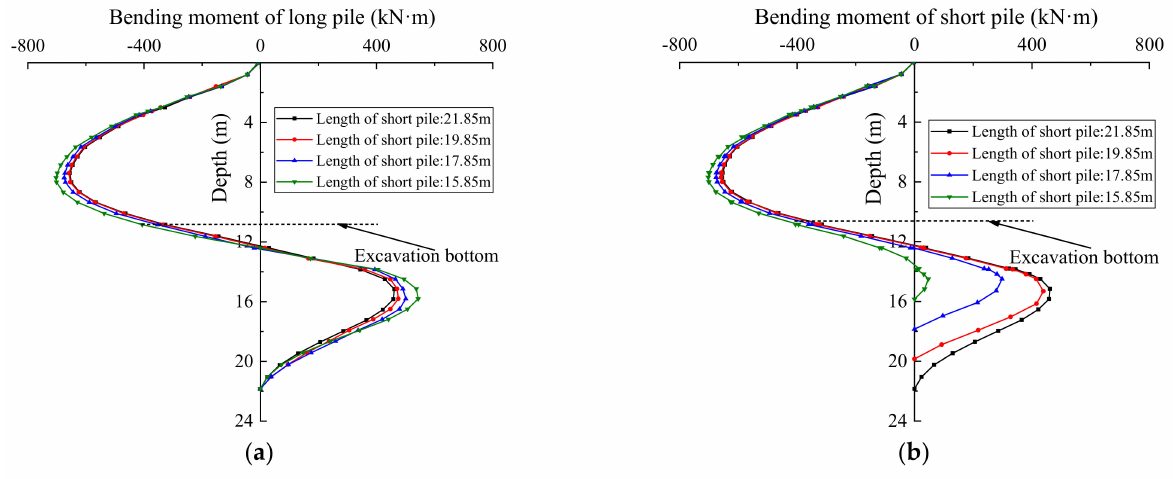
Figure 15. Bending moment of piles under different short pile lengths: ( a ) long pile; ( b ) short pile.